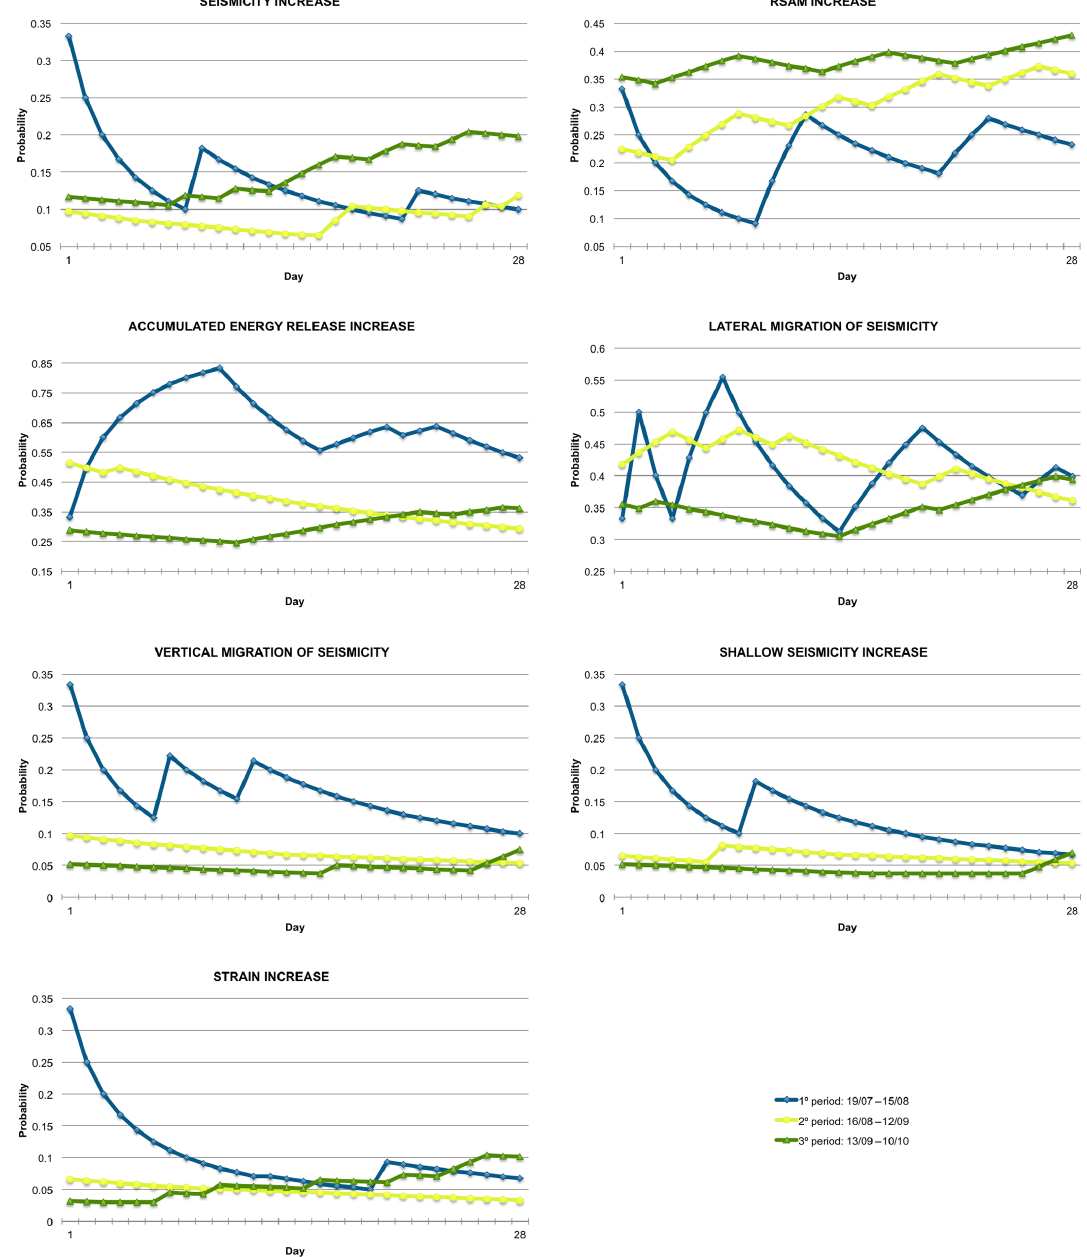
Figure 5. ST HASSET: the evolution of all indicators every 28 days (three phases of